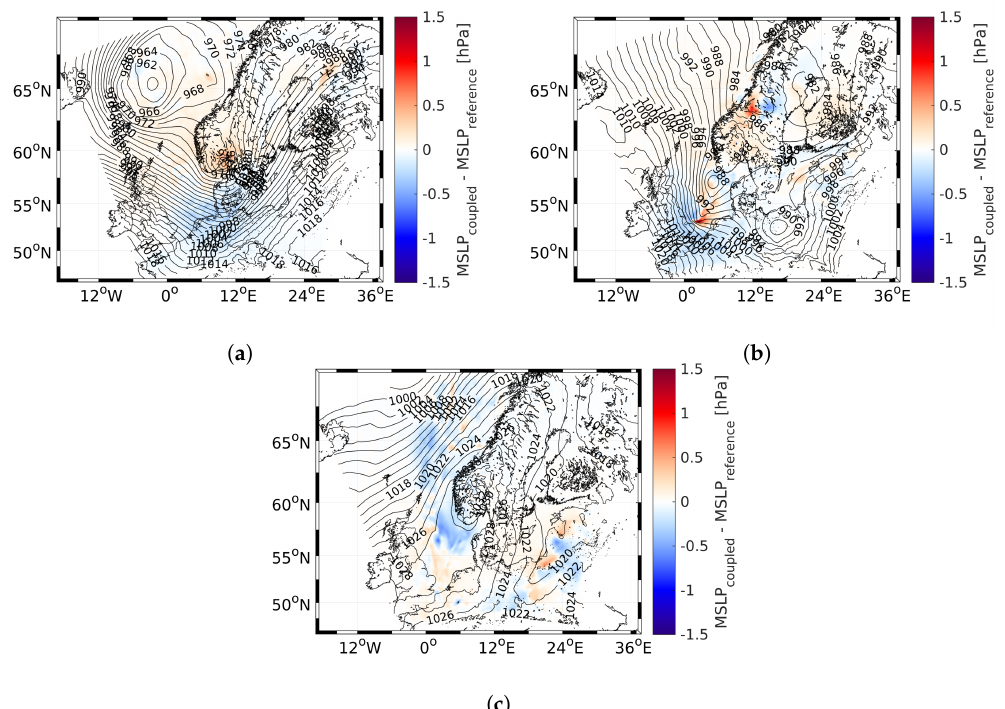
Figure 11. Absolute values of the MSLP in the reference model simulation (contours) and the differences in the MSLP between the coupled and reference model simulations (coloured) on ( a ) 11 January 2017 at 12:00 p.m. UTC; ( b ) 13 January 2017 at 12:00 p.m. UTC; and ( c ) 16 January 2017 at 6:00 a.m.